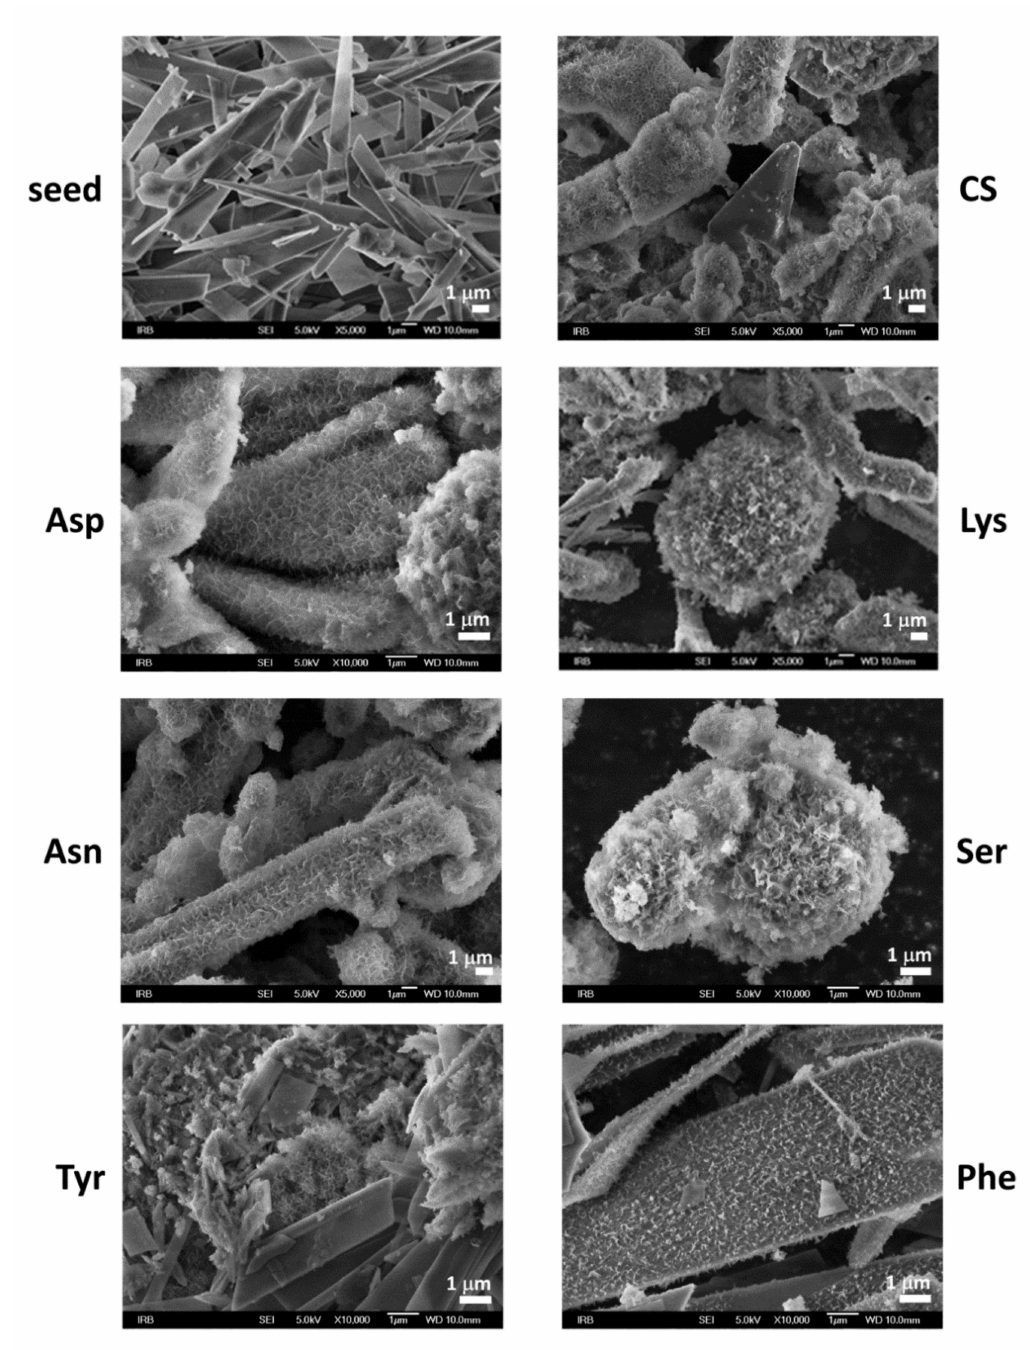
Figure 2. SEM micrographs of octacalcium phosphate (OCP) seed crystals as well as precipitates formed in the control system (CS) and in the presence of di ff erent amino acids after aging time corresponding to commencement of stage III in pH vs. time curves in the system c (CaCl 2 ) = c (Na 2 HPO 4 ) = 4.198 mmol dm − 3 , c (NaCl) = 0.148 mol dm − 3 , m (seed OCP) = 1 mg, γ (AA) = 10 ppm, except γ (Phe) = 5 ppm. t = 25 ◦ C, pH initial = 7.4, magneticstirring. Asp—L-aspartic acid,